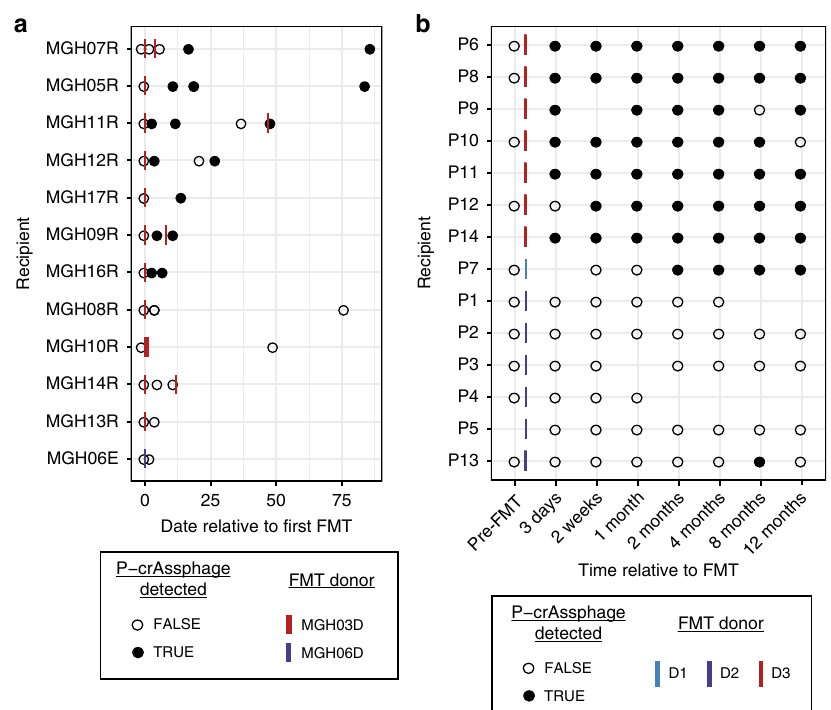
Fig. 5 P-crAssphage status in patients receiving FMT over time. a P-crAssphage detection at 1x coverage in samples from Smillie et al. 35 Both donors shown were p-crAssphage positive. Open circles represent a p-crAssphage negative samples and closed circles represent p-crAssphage positive samples. b P-crAssphage detection at 10x coverage in samples from Draper et al. 37 Donor D1 was p-crAssphage positive, while donors D2 and D3 were p-crAssphage